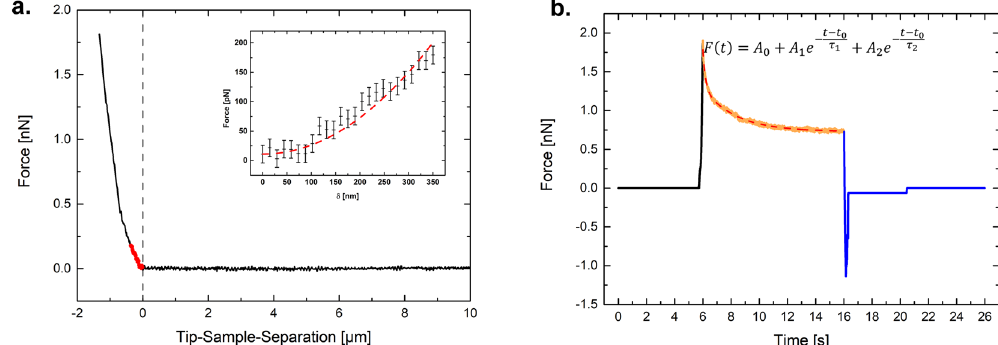
Figure 3. Representative forces curves and mechanical models used in this study. ( a ) Force-Distance curve for the indentation segment. Highlighted in red is the region for which the Hertz model with Sneddon extension is fitted (350 nm). The insert shows the fitting. ( b ) Force-Time curve for a whole measurement, with indentation (black), stress relaxation (orange) and retraction (blue). The fit for the used stress relaxation model is seen as a dashed red line. The equation used is shown in the inset (see the Methods section for more information).